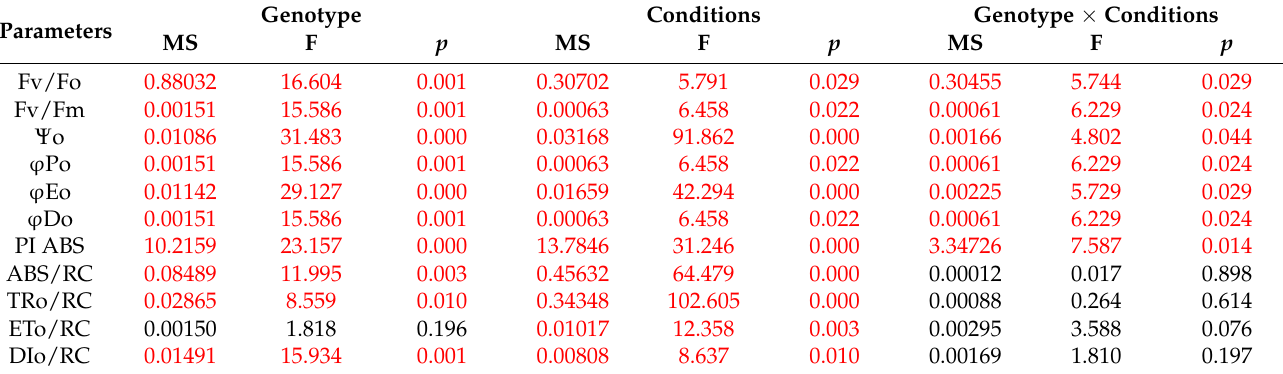
Table 5. Results of two-way ANOVA for two barley genotypes (Golden Promise and Haruna Nijo) grown under two conditions (control conditions and salt stress induced by 150 mM sodium chloride) were calculated for photosystem II efficiency, measured in the 3rd leaf (Fv/Fo, PSII potential activity; Fv/Fm, PSII maximum photochemical efficiency; Ψ o, probability (at t = 0) that a trapped excitation moves an electron into the electron transport chain beyond QA; ϕ Po, maximum quantum yield of primary photochemistry (at t = 0); ϕ Eo, quantum yield of electron transport (at t = 0); ϕ Do, quantum yield (at t = 0) of energy dissipation; PI ABS, performance index (potential) for energy conservation from an exciton to the reduction of intersystem electron acceptors; ABS/RC, absorption flux (of antenna Chls) per RC; TRo/RC, trapping flux (leading to QA reduction) per RC; ETo/RC, electron transport flux (further than QA − ) per RC; DIo/RC, dissipated energy flux per RC (at t = 0)).